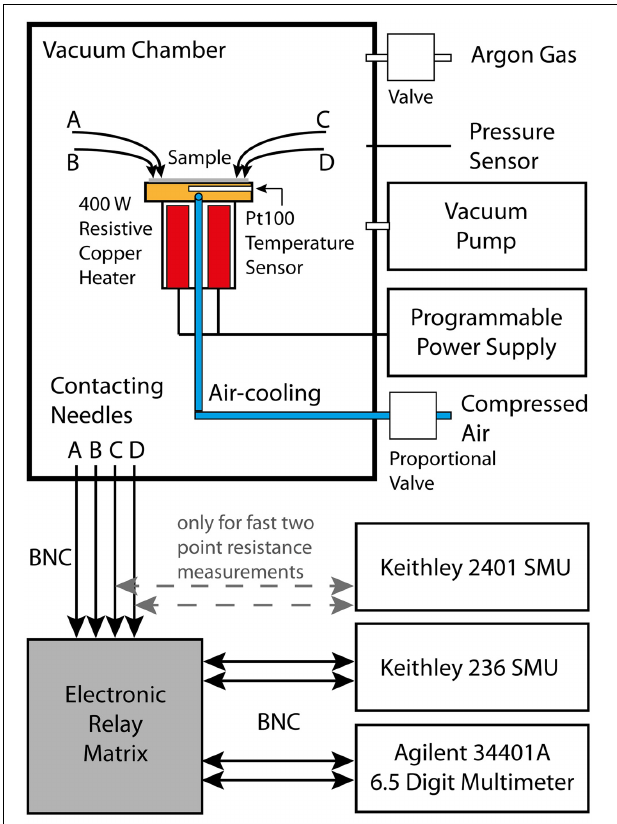
FIGURE 1 | Schematic illustration of the Van-der-Pauw setup. The samples are positioned on top of a temperature controlled copper block inside a vacuum chamber. Before starting the measurement the vacuum chamber is first evacuated and afterwards flushed with pure argon gas. Four 100W resistive heater cartridges enable us to heat up the sample (e.g., with a rate of 1K/s) to about 650K. Whereas, cooling is done by passing compressed air through a small pipe in the copper block. Both the electrical power supply for the heating cartridges and the proportional valve for the compressed air inlet are PID controlled. The electrical contact is realized by four gold-plated and spring-supported needles, which can be moved to different contact pads on the sample. A custom-made electronic relay matrix connects a source-measuring-unit (SMU) and a multimeter to any of the contact needles. For fast two-point resistance measurements a second SMU is directly connected to two of the needles.